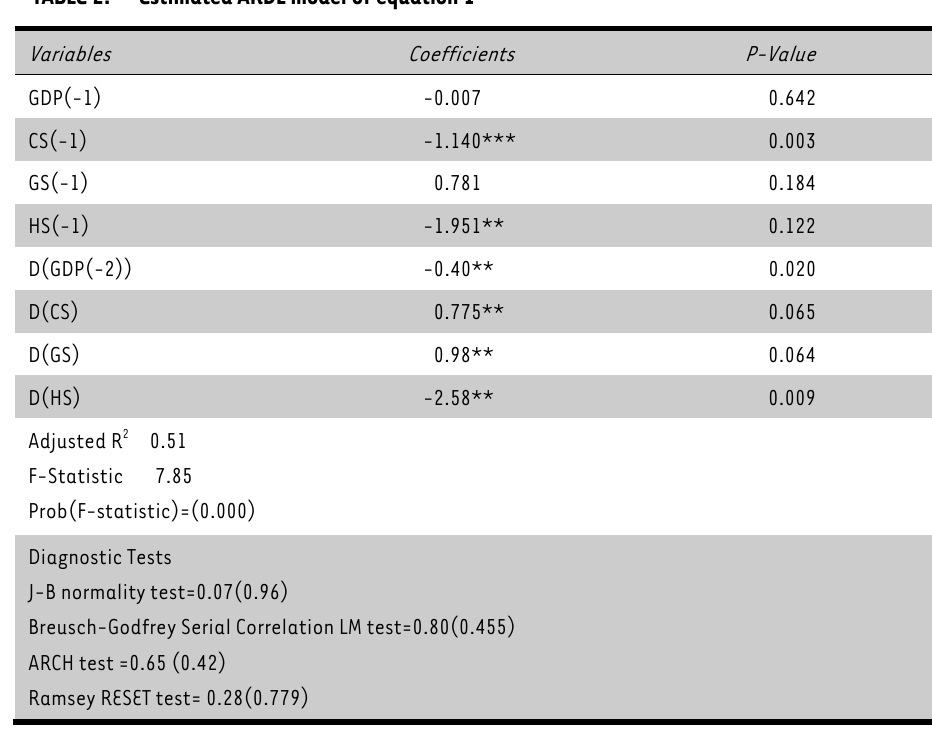
=4.70 is greater than the 𝐹 𝐺𝐷𝑃 ( 𝐺𝐷𝑃 / 𝐶𝑆 , 𝐺𝑆 , 𝐻𝑆 )